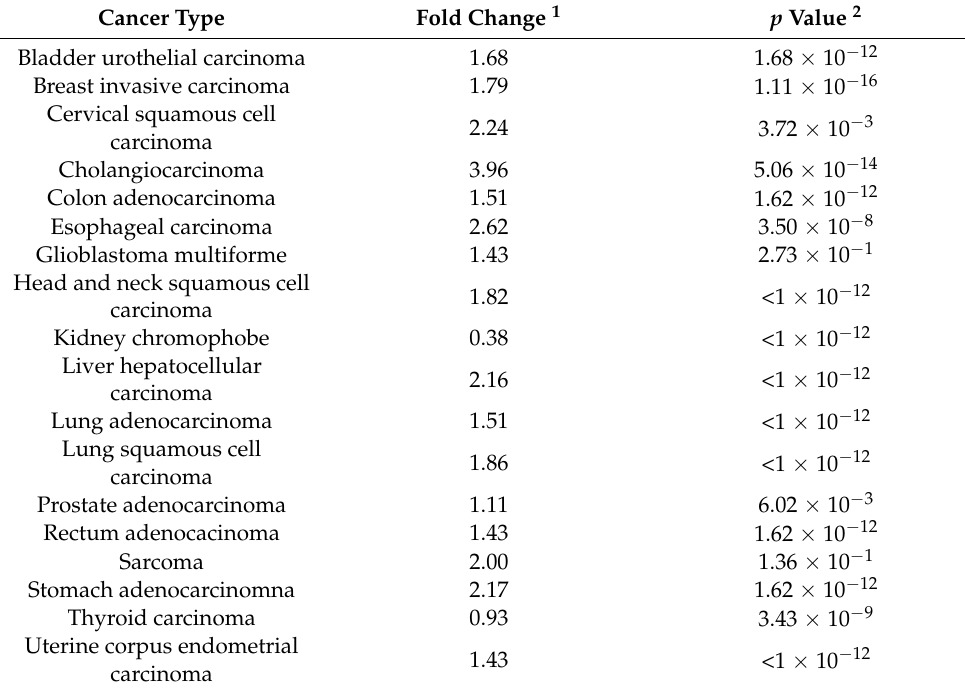
Table 1. Comparison of BUB3 expression between cancers and normal